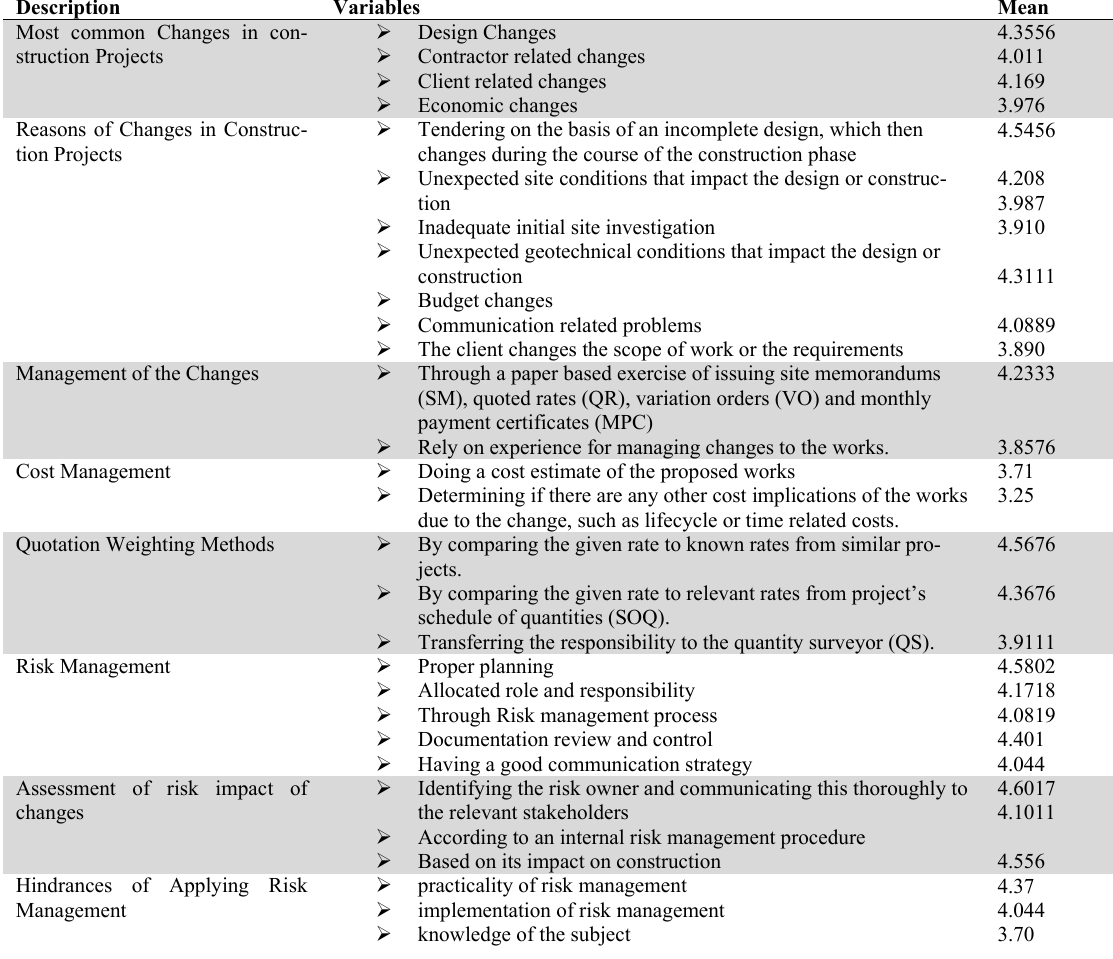
Descriptive Analysis of each part of the questionnaire and top rated